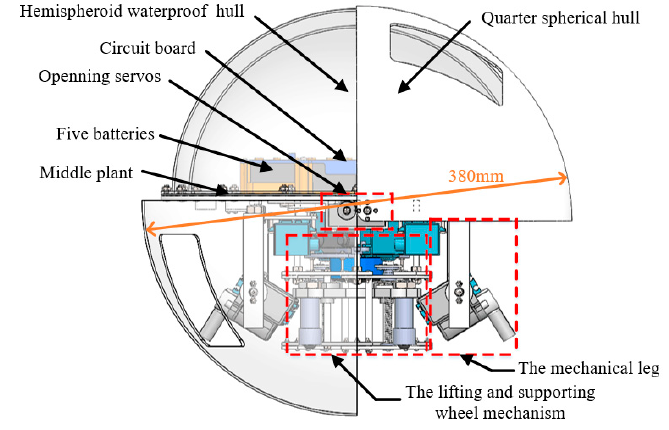
Figure 1. The novel amphibious spherical robot III (ASR-III).